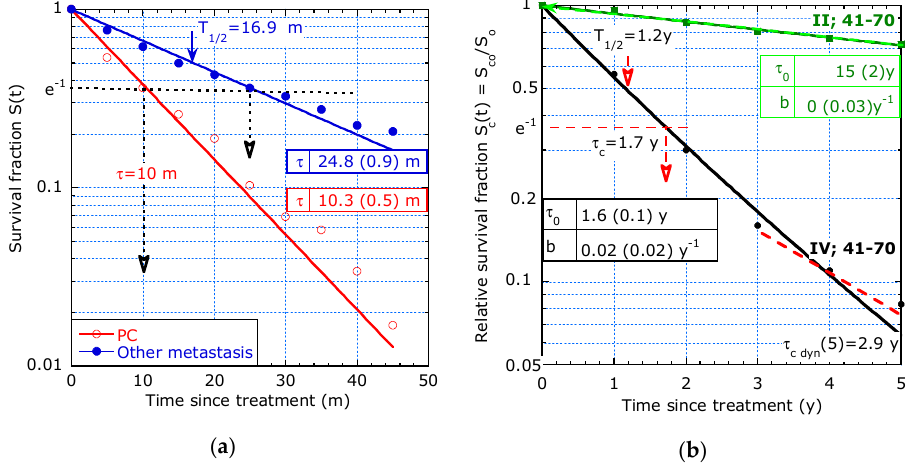
Figure 4. Survival estimation with exponential decay or a sliding- τ model with b ≈ 0: ( a ) After curative treatment of CRC (mainly stage III) with PC (circles) and other metastases (dots) ([3], Figure 2); ( b ) Relative survival of patients in the age group 41–70 years old, stage II (squares) and IV (dots) ([4], Figure 1.